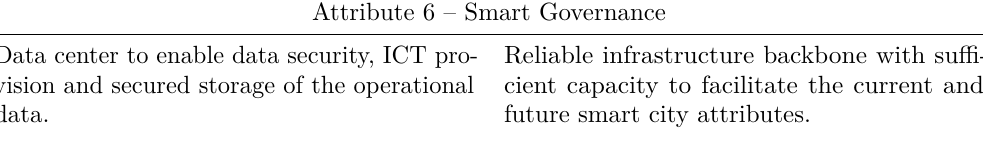
Table 1. Appraisal of the Smart City Features in the South-east Asia